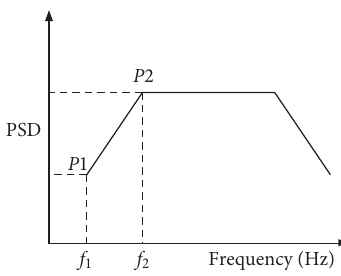
Figure 1: Typical random vibration input PSD